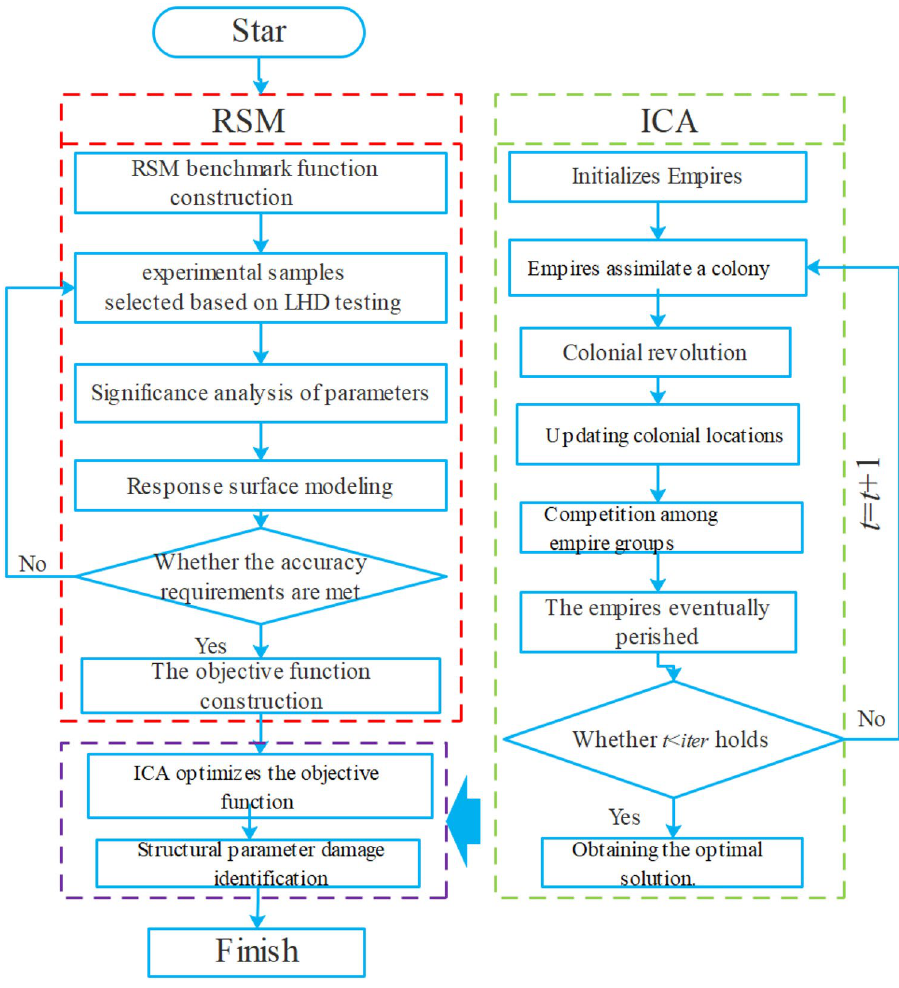
Figure 2. Flow chart of SDI based on